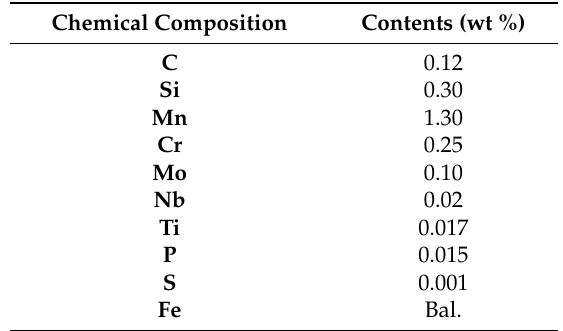
Table 1. Chemical composition of the investigated steel (wt